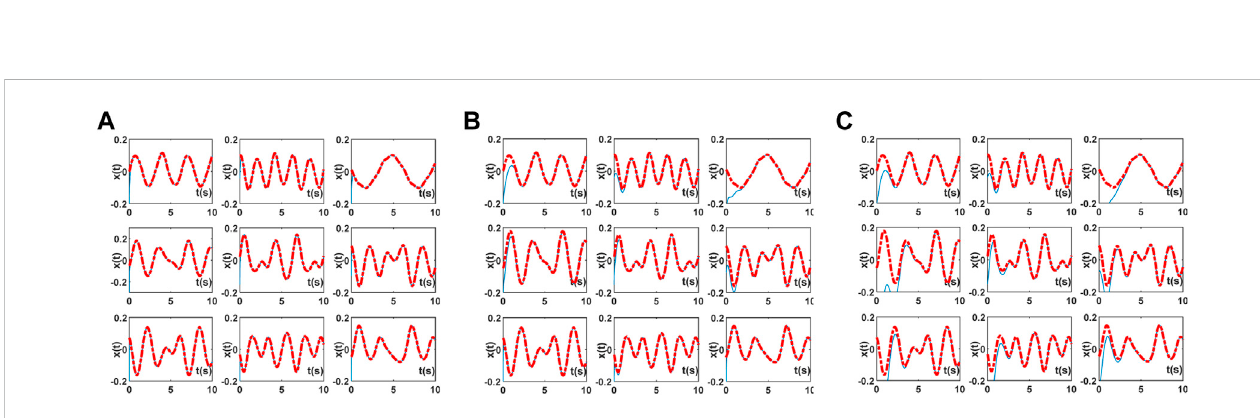
FIGURE 3 Thecomparisonofthestatesolutionandthetheoreticalsolution: (A) SSofNAFforsolvingTDSE; (B) SSofPSAFforsolvingTDSE; (C) SSofLAFforsolving